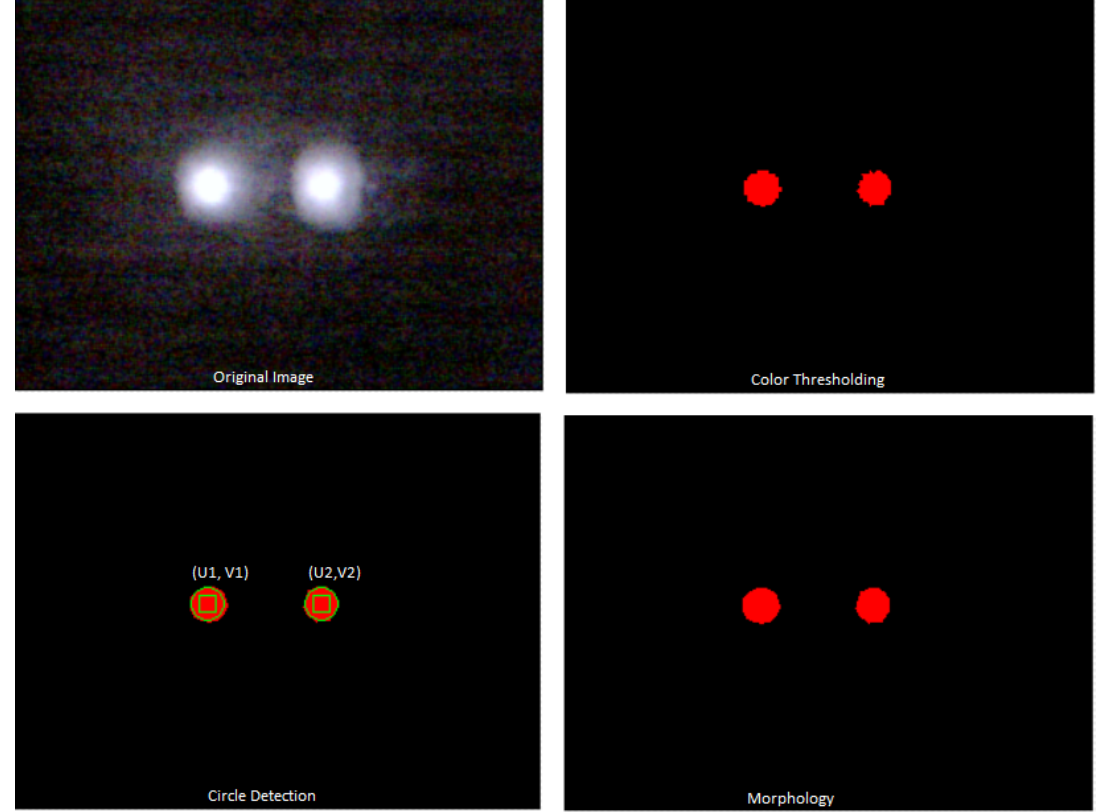
Figure 2. Blob detection and tracking algorithm outputs.